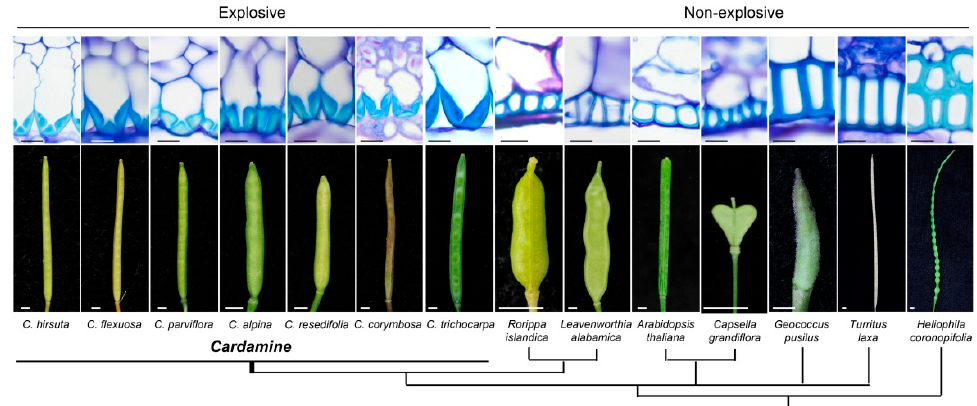
Figure 2. Representative patterns of secondary cell-wall lignin deposition in the endocarp b tissue for various species of the Brassicaceae family (as indicated) that are characterized by explosive ( Cardamine ) and non-explosive silique shattering. Top : Light microscopy transverse valve sections of mature fruit with cell walls stained with toluidine blue O. Bottom : Mature wild-type fruit. Phylogenetic relationships between species are shown in the cladogram. Scale bars: 10 mm, cells; 2 mm, fruit (reproduced with permission from Hofuis et al. [25]).